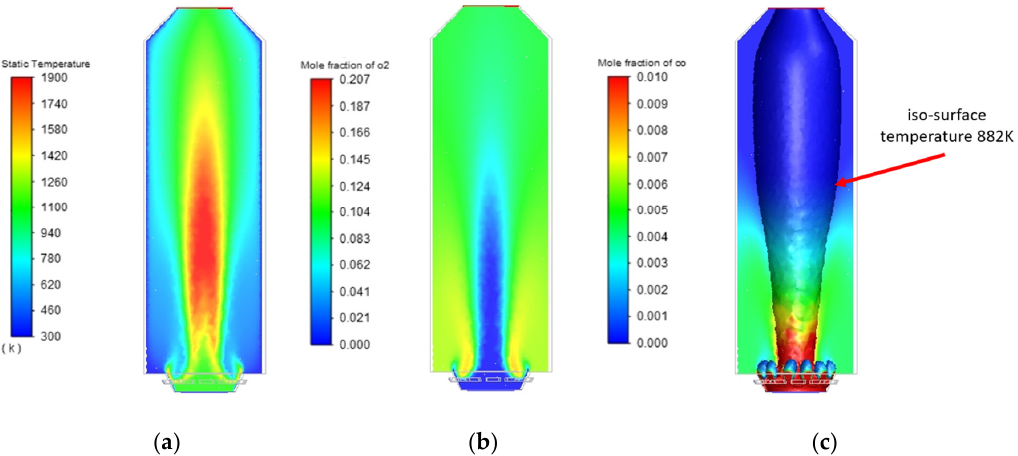
Figure 5. ( a ) Temperature distribution (K); ( b ) O 2 (mole fraction); ( c ) CO (mole fraction) for the 1st phase of numeric modelling.